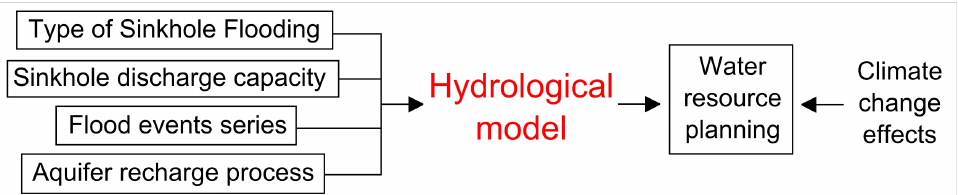
Figure 4. Relationship diagram among the topics identified by the